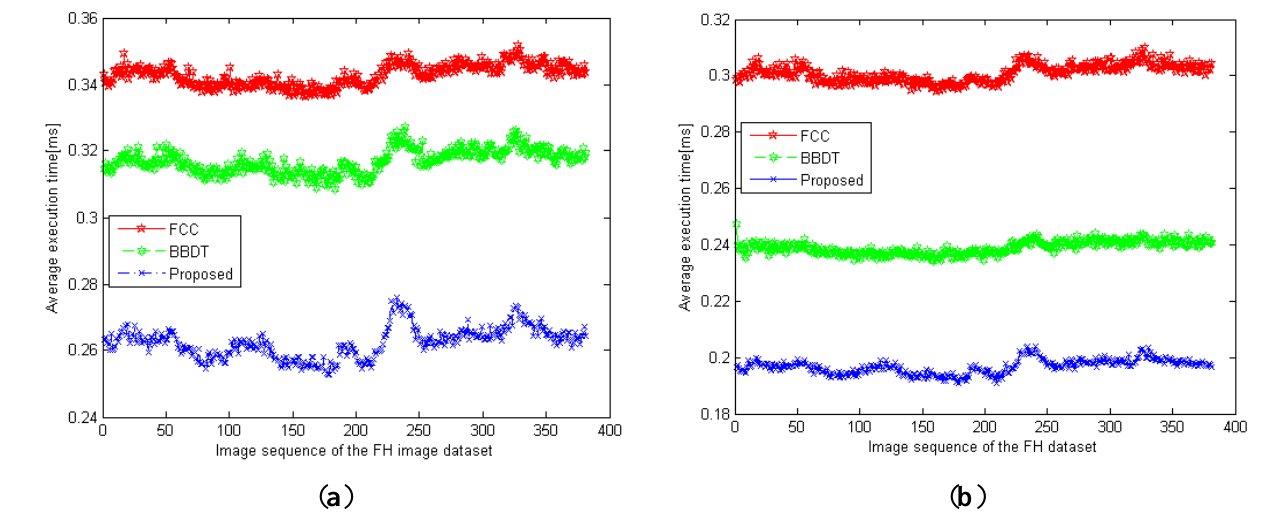
Figure 12. Average execution times of the three labeling algorithms versus the image sequence of the FH image dataset: ( a ) the entire algorithm, and ( b ) the first-scan